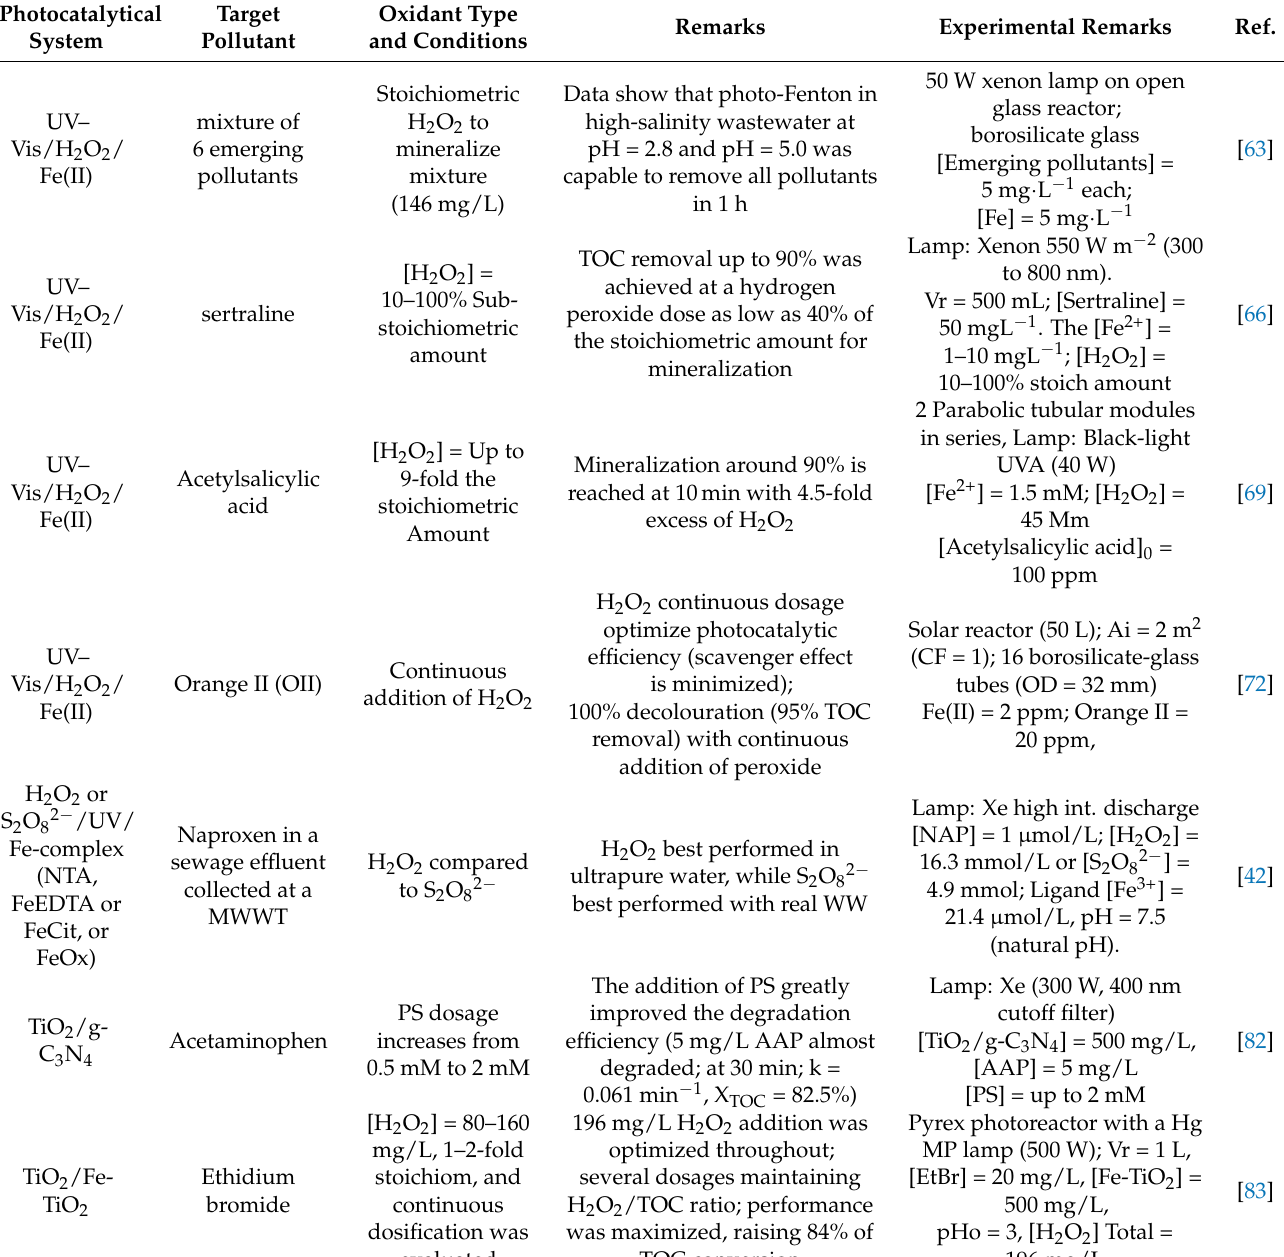
Table 4. UV-AOPs intensification by oxidant usage